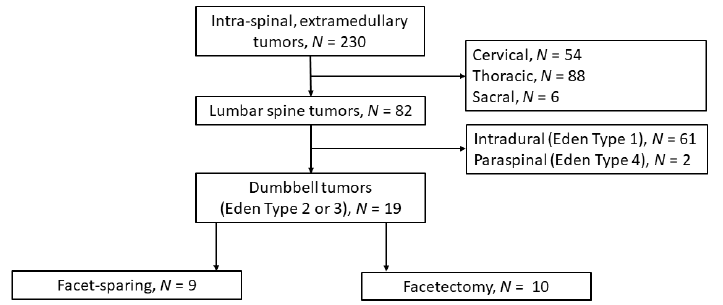
Figure 1. Flow chart of patients included to the study.